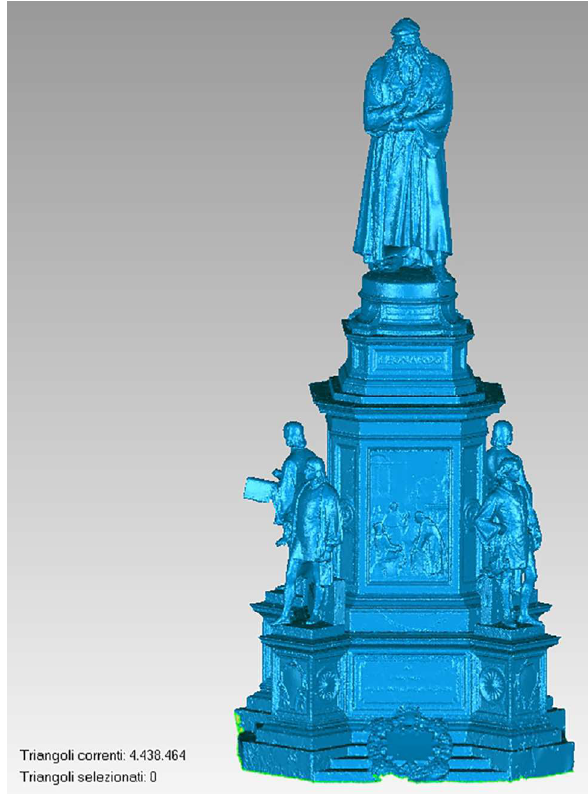
Figure 4. Reverse modelling of the monument